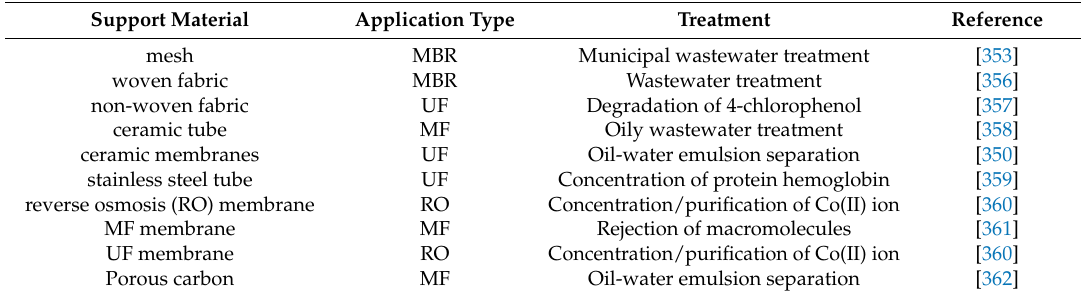
Figure 17. ( A ) Cross-section SEM of support ceramic membrane; ( B ) pre-coated composite membranes and ( C ) self-forming composite membranes [350]. Reproduced with permission from [350]. Table 7. List of different studies on dynamic membranes with different support materials.